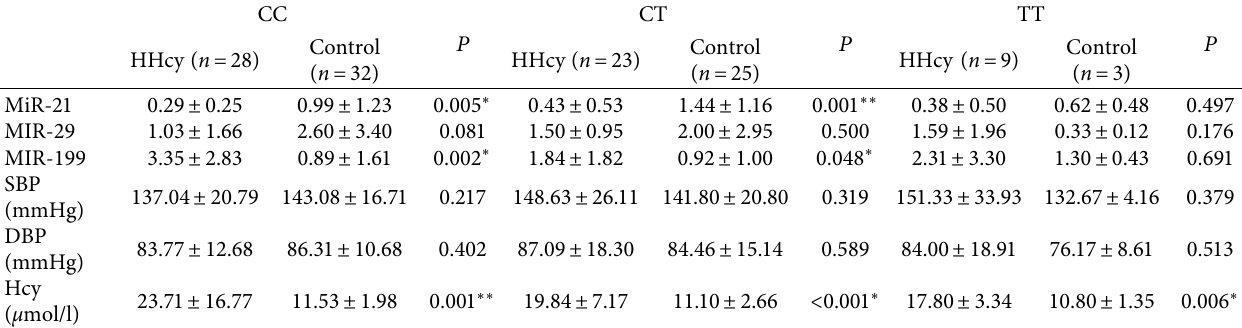
Table 4: Comparison of miRNA, blood pressure, and hcy levels of different genotypes of MTHFRC677T. CC